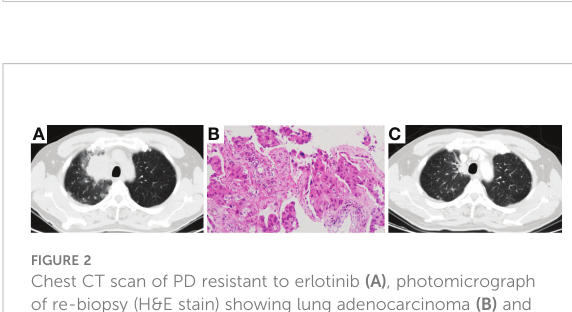
FIGURE 1 Chest CT scan of baseline (A, B) , pathological examination (H&E stain) showing lung adenocarcinoma (C) and chest CT scan of best response PR after the treatment of Erlotinib (D) . CT, computed tomography; PR, partial